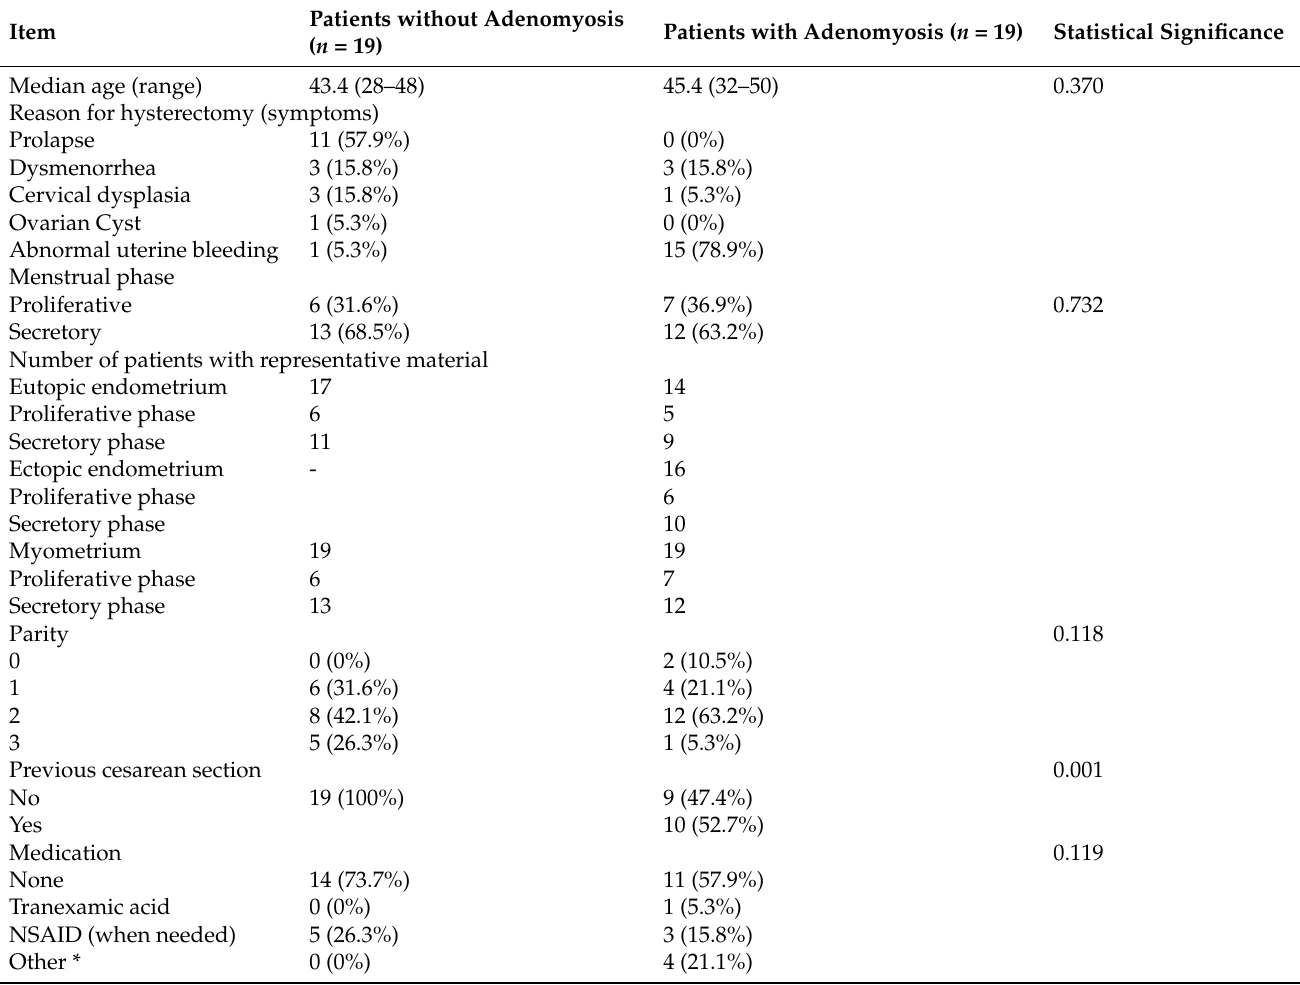
Table 1. Characteristics of adenomyosis patients and